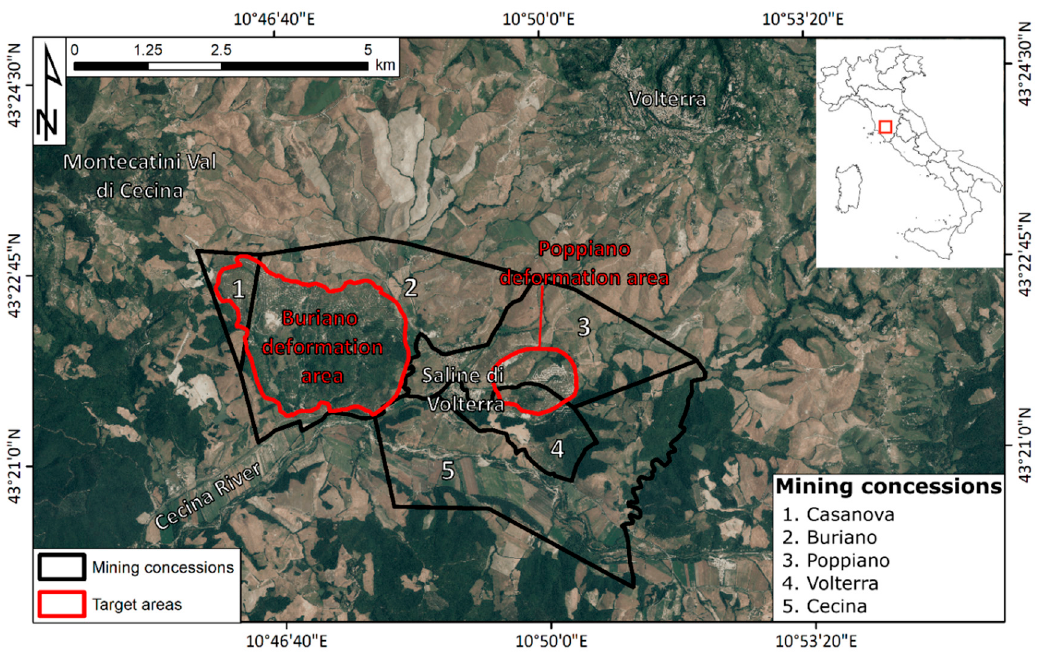
Figure 1. Localization of the area of interest and of the mining concessions in the surroundings of Saline di Volterra in the Volterra Municipality. The background image is a 20 cm AGEA orthophoto (from